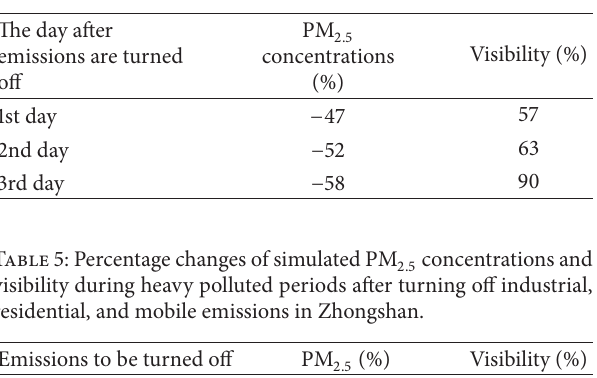
Table 4: Percentage changes of simulated PM 2.5 concentrations and visibility after local emissions are turned off in Zhongshan.